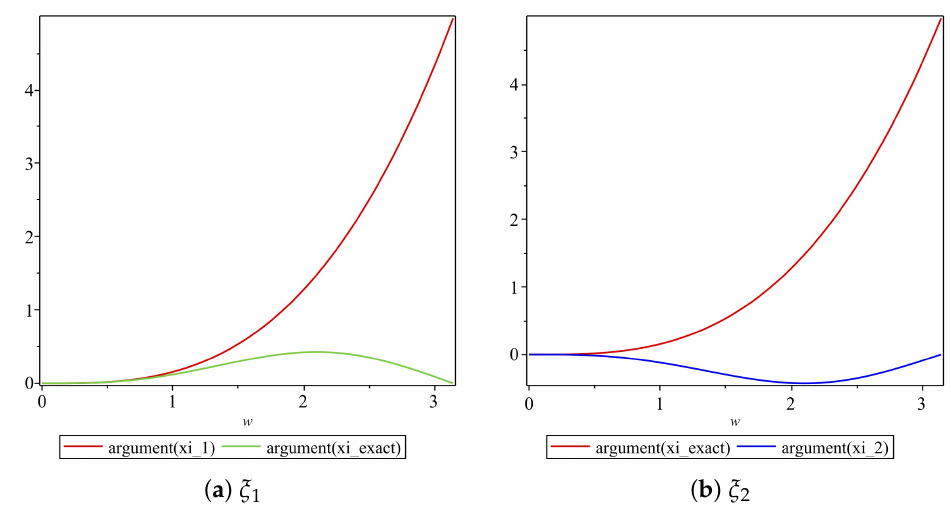
Figure 20. Plot of the arguments of amplification factors of Scheme 1 for Numerical Experiment 2 with the spatial and temporal step sizes h = π /10 and k = 0.001,